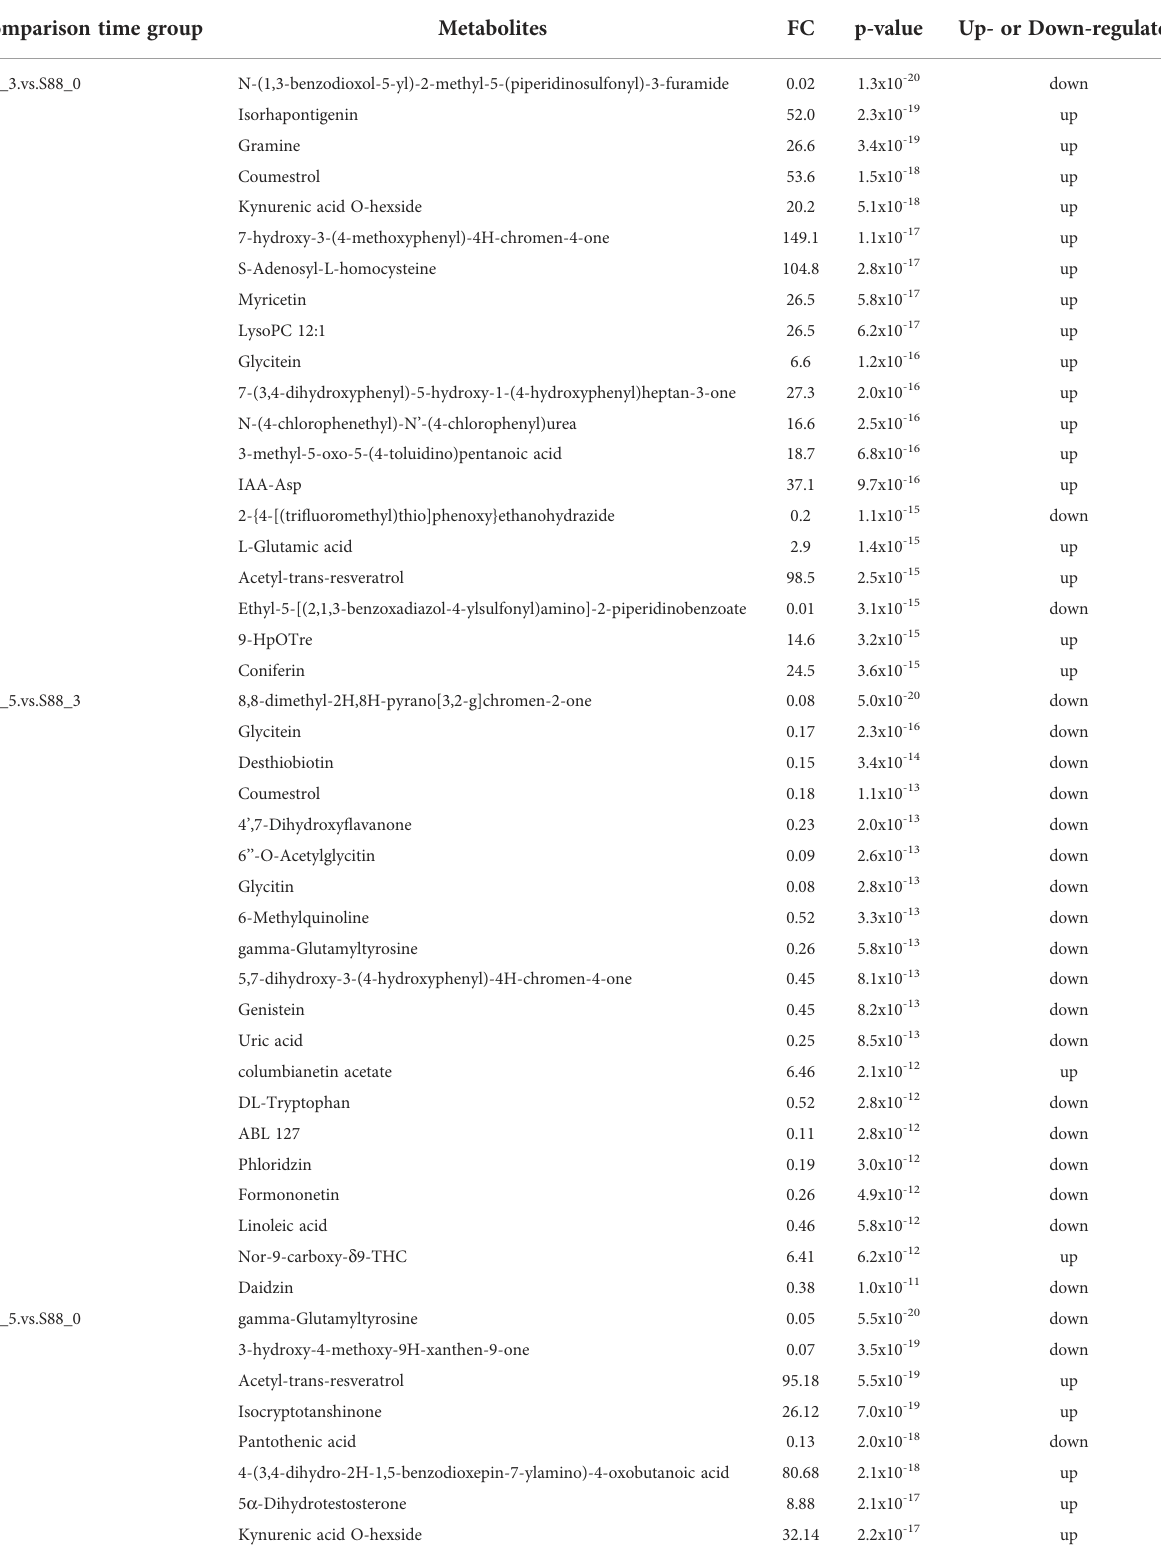
TABLE 1 Comparison of different metabolites of soybean samples in three groups based on the inoculation time of F. fujikuroi . Comparison time